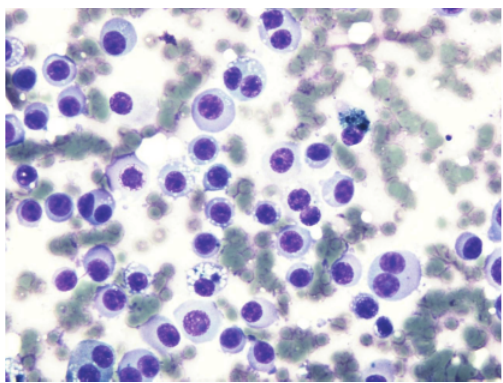
Figure 2: Smear dominated by large mononuclear cells with slightly condensed basophilic cytoplasm and enlarged nucleoli.